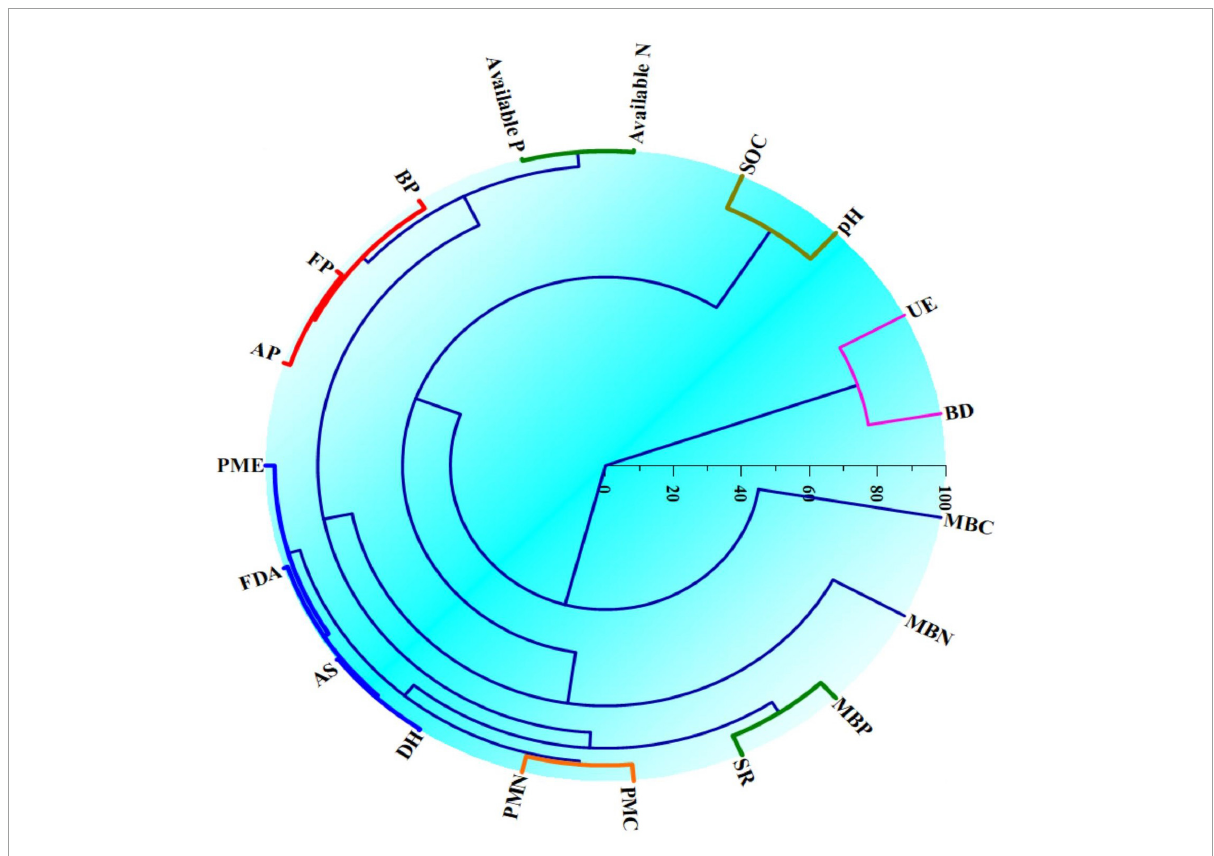
FIGURE4 Hierarchical clustering of the soil biological entities indicating similarities in different soil physico-chemical and biological entities in cauliflower-cowpea–okra cropping system. MBC, microbial biomass carbon; SR, soil respiration; MINC, mineralizable carbon; MINN, mineralizable nitrogen; AP, actinomycetes population; BP, bacterial population; FP, fungal population; AS, arylsulphatase activity; DHA, dehydrogenase activity; FDA, fluorescein di-acetate hydrolysis activity; PMA, phosphomonoesterase activity; UE, urease activity; VS, vegetative stage; CIS, curd initiation stage; MS, maturity stages are the Blevels,